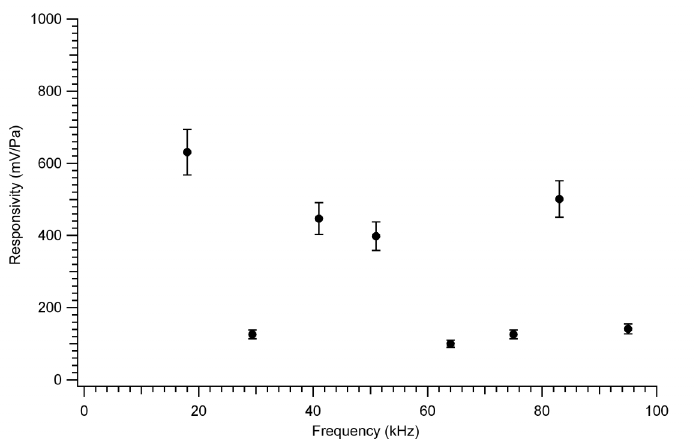
Fig. 9. FL responsivity for different test note frequencies; OPD ~ 450m; FL optical power 10 µ